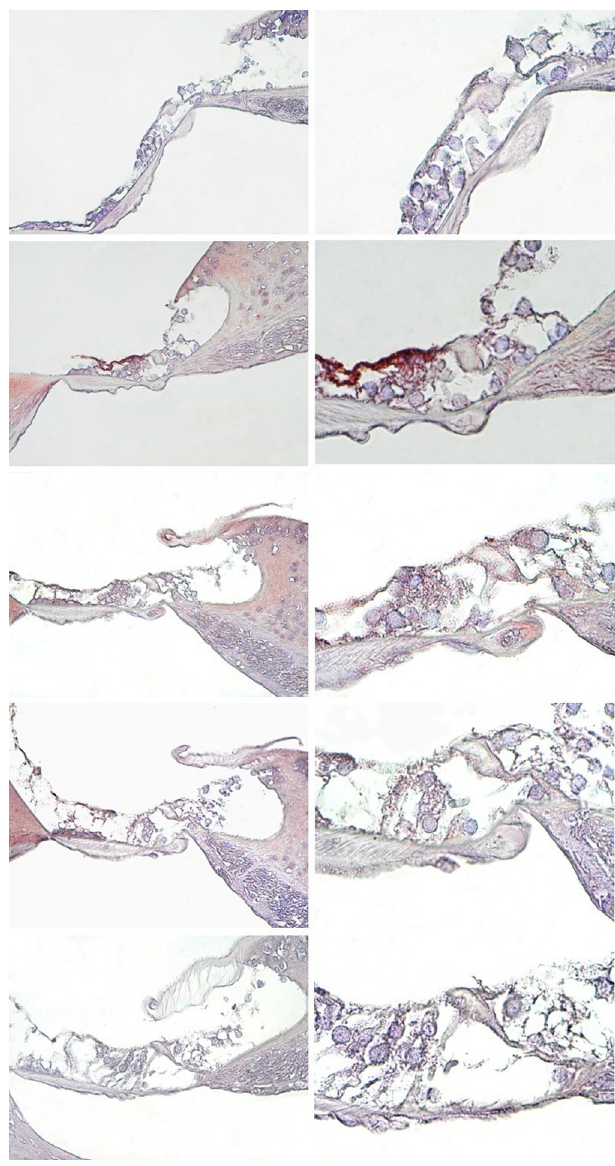
Fig 3. Cytocrome-c immunohistochemistry staining in the cochlear Corti organ of the rat groups. ! : İ nner hair cells, ⇉ : Outer hair cells, Slm: Spiral limbus, Slg: Spiral ligament, BM: Basilar membrane, Control (A), DM (B), DM +PTS10 (C), DM+PTS20 (D), DM+PTS40 (E). Corti organ X40 (1), Corti organ X100 (2). Methyl-green ground staining.